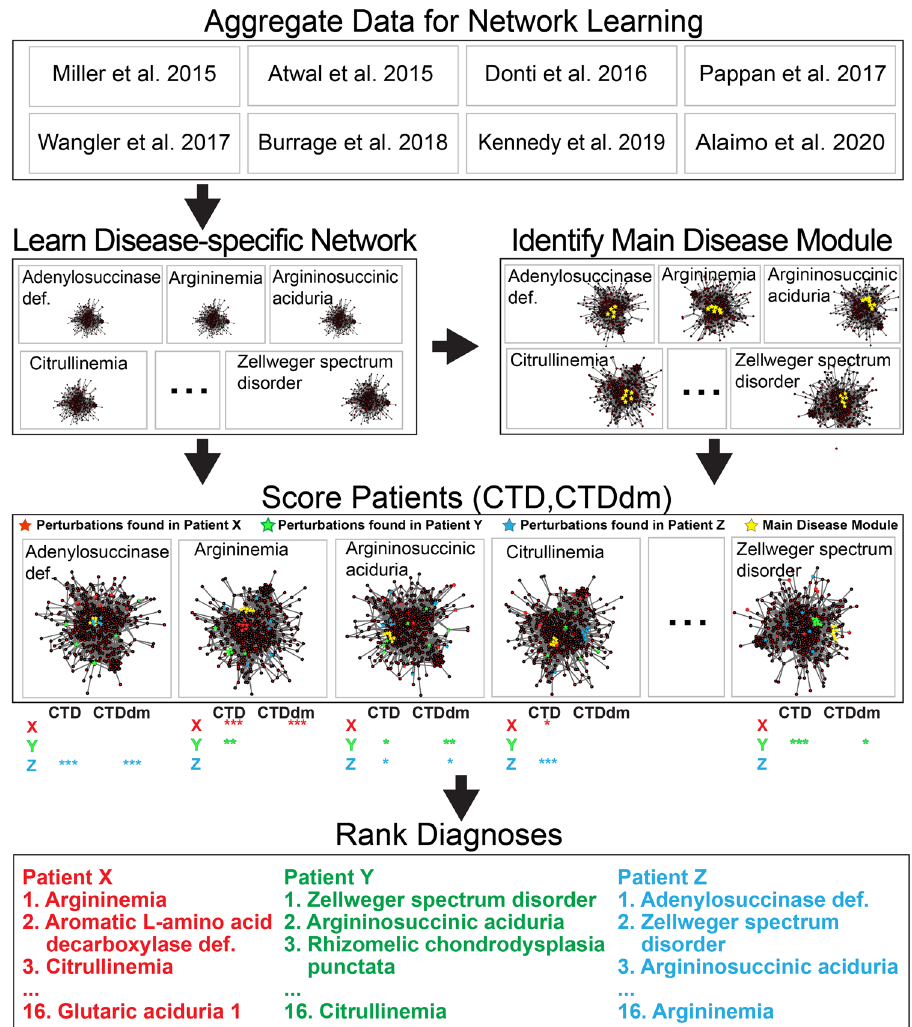
Figure 1. Overview of CTD-based data-driven diagnostic